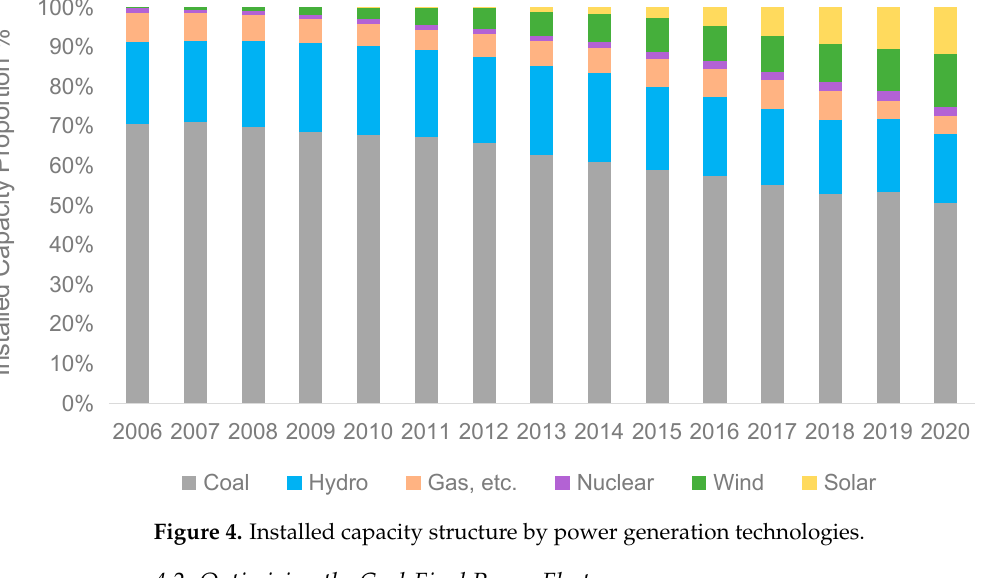
Figure 4. Installed capacity structure by power generation technologies.